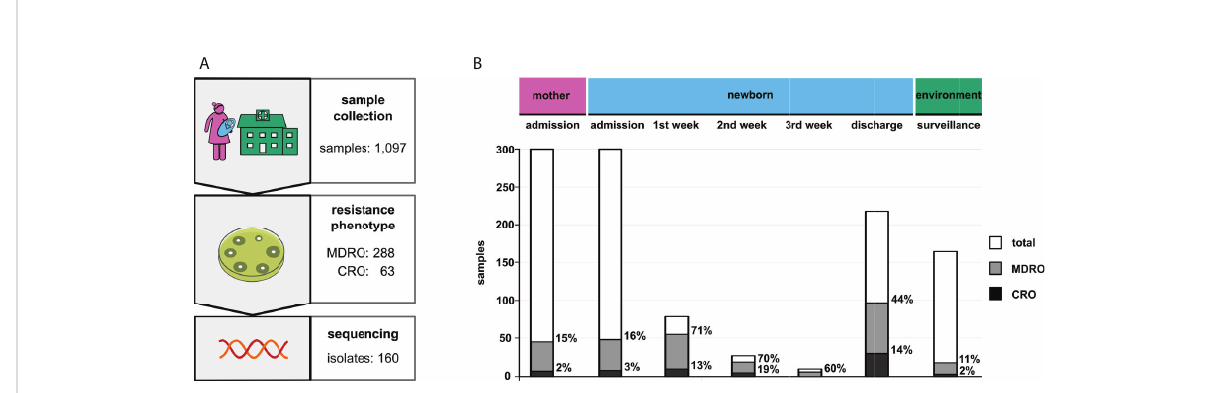
FIGURE 1 Results of the surveillance study. (A) Study design including the respective sample numbers (MDRO, multidrug-resistant organisms; CRO, carbapenem-resistant organisms). (B) Total prevalence of the identi fi ed bacteria grouped by sample type. “ Admission ” and “ discharge ” refer to the particular hospital stays of patients. Column sizes indicate absolute numbers, while percentages of MDRO and CRO are given next to the respective